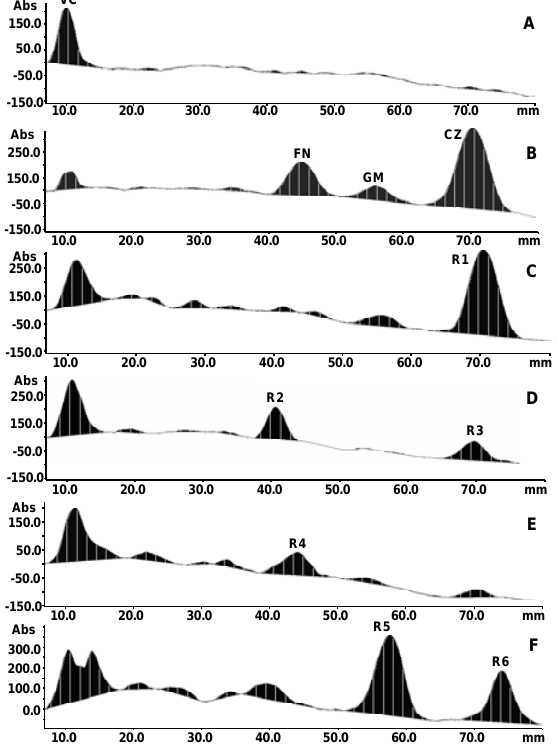
Figure 2. Typical TLC densitograms of vitamin C (A), mixed standards (B), methanol extracts of C. wenyujin (C), C. kwangsiensis (D), C. phaeocaulis (E) and C. longa (F) colorized with 0.04%DPPH.